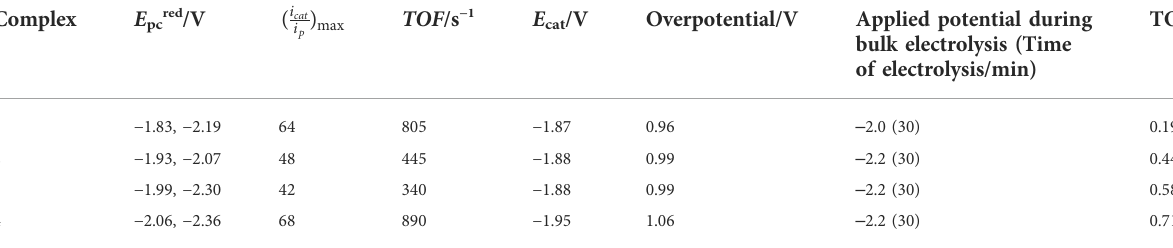
TABLE 1 Electrochemical data for complexes 1 – 4 in